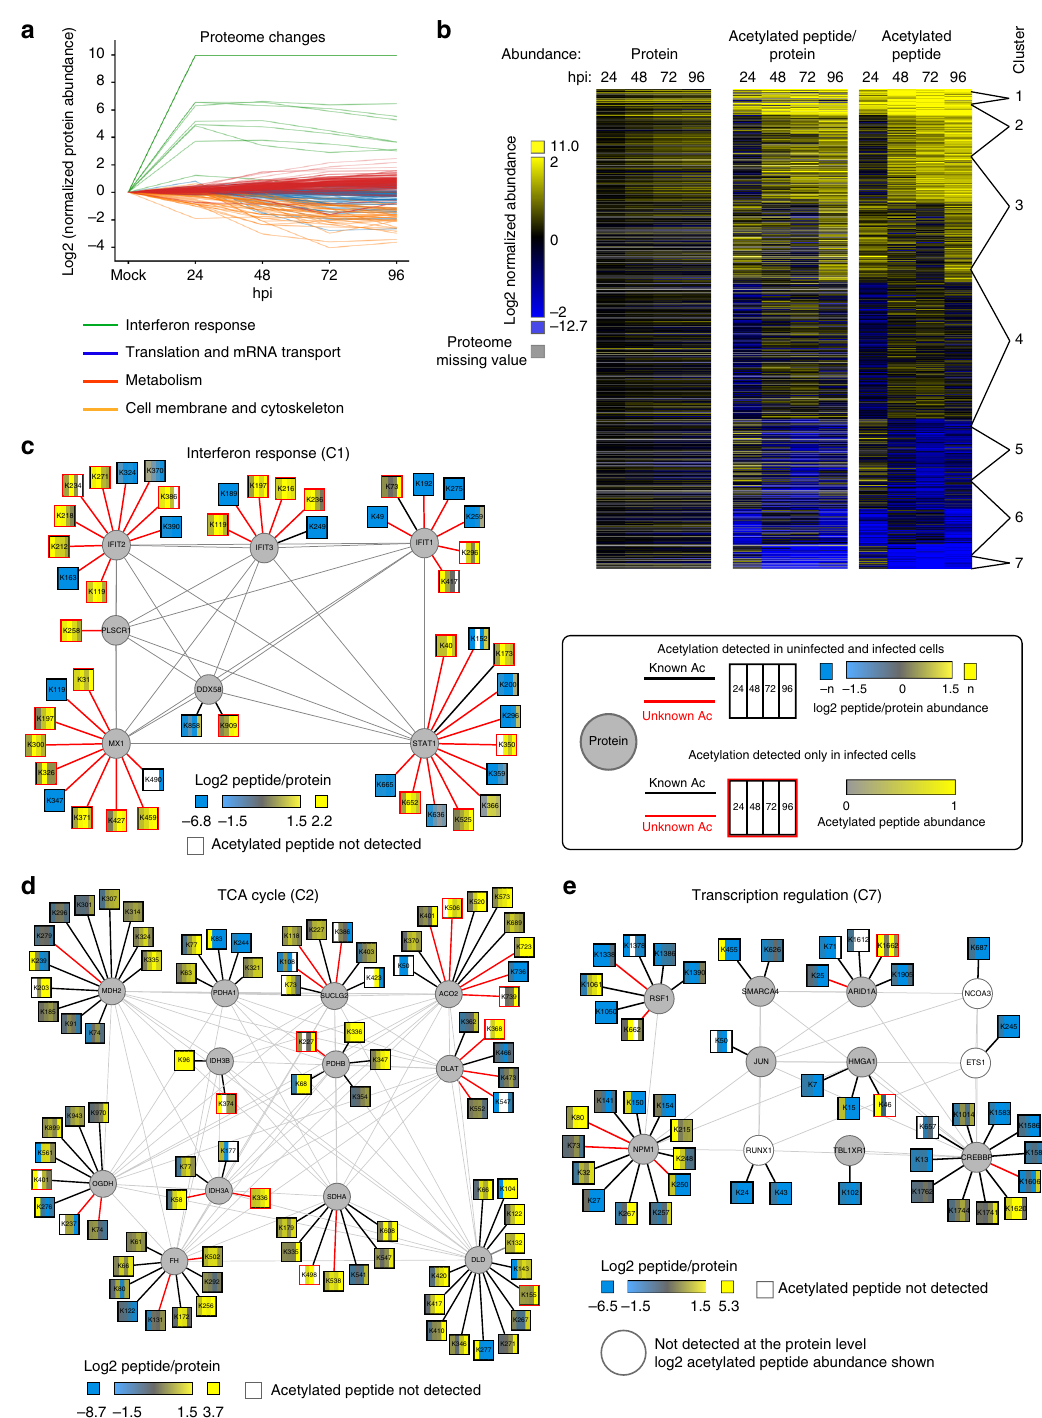
Fig. 3 Acetylation increases on proteins in immune response and metabolic pathways and decreases on transcriptional regulators. a Protein abundances in infection were normalized to mock abundances and plotted as log2 values. Four biological processes relevant to HCMV infection that display distinct protein abundance trends are illustrated. b K-means clustering was conducted in C3 ( k = 7) to cluster changes in peptide acetylation levels at different time points of infection when compared with uninfected cells (right column). Whole-cell protein abundances (left) and peptide acetylation levels normalized to protein abundance (middle) are illustrated. Increased abundance, yellow; decreased abundance, blue; not detected in the proteome, gray. c – e Detected acetylation sites on proteins from indicated functional clusters representing site-speci fi c regulation of acetylation during infection. Circles, proteins; squares, acetylation sites; red lines, previously unknown acetylation sites; black lines, known acetylation sites; red boxes, sites only detected during infection with abundances displayed on a 0 – 1 scale as they could not be normalized to mock samples; white bars, acetylated peptide not detected. c interferon response, d TCA cycle, e